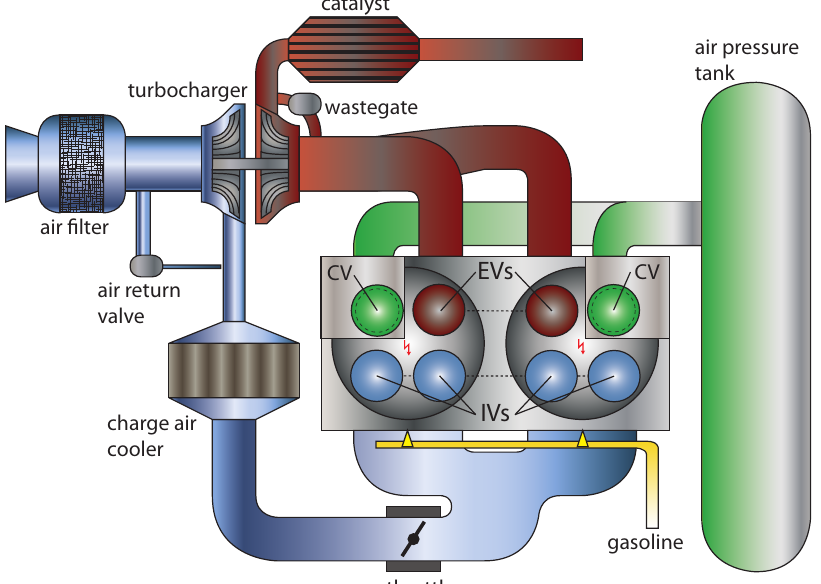
Figure 1. Schematic of the directly air-assisted turbocharged SI engine: intake valve (IV), exhaust valve (EV) (Figure taken from